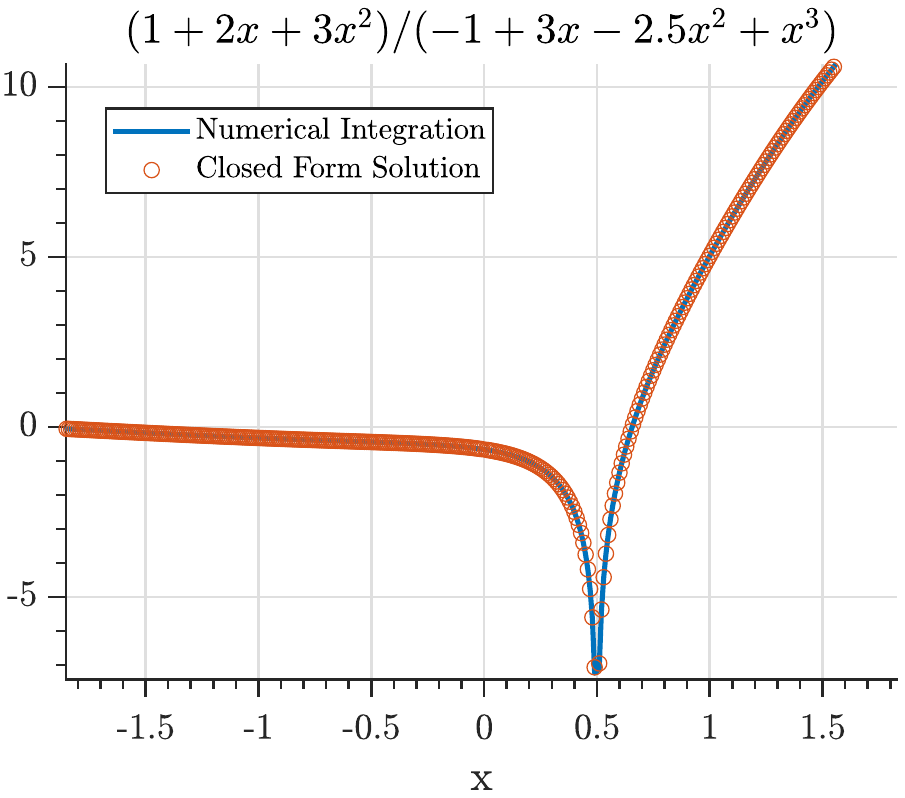
Figure 1. Numerical validation for a linear exponentiated denominator ( r = 1 ) . The roots are a mix of purely real and complex x 1,2,3 = { 1/2,1 − i ,1 + i } . The singular point at x = 0.5 was manually removed to avoid large divergences in the